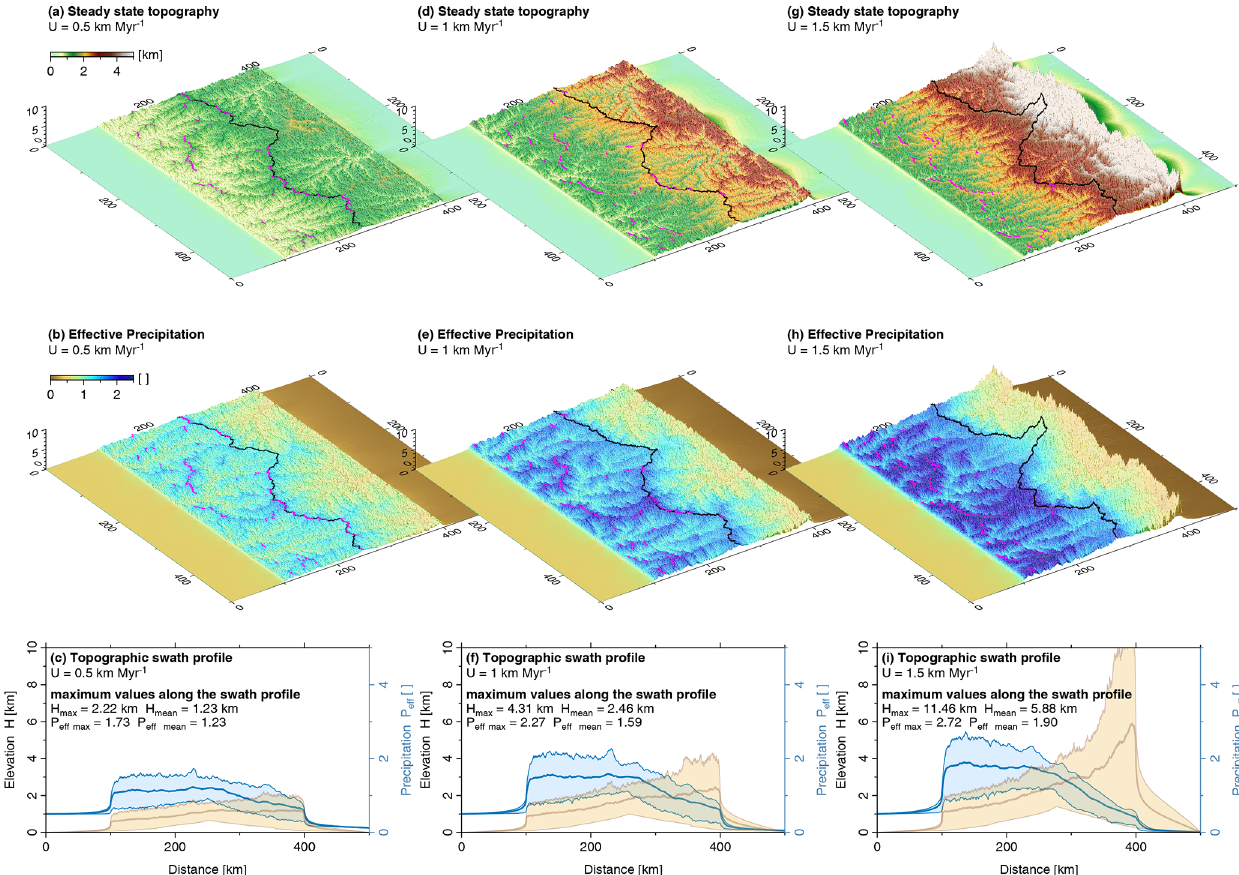
Figure 9. Impact of uplift rate on the precipitation pattern and on mountain geometry for K = 2 . 5Myr − 1 , L l = 500km, L c = L f = 25km, L d = 5km, and (cid:15) = 0 . 5. (a, d, g) Steady-state mountain topographies representing uplift rates of 0.5, 1.0, and 1.5kmMyr − 1 . The black solid line indicates the main drainage divide. Magenta dots mark the position of maximum precipitation in the windward direction. (b, e, h) The corresponding precipitation patterns and (c, f, i) south–north-trending swath profiles representing topography (brown) and effective precipi- tation (blue) with average (thick solid line) and extreme values (thin solid lines) taken over the full west–east extent of the model